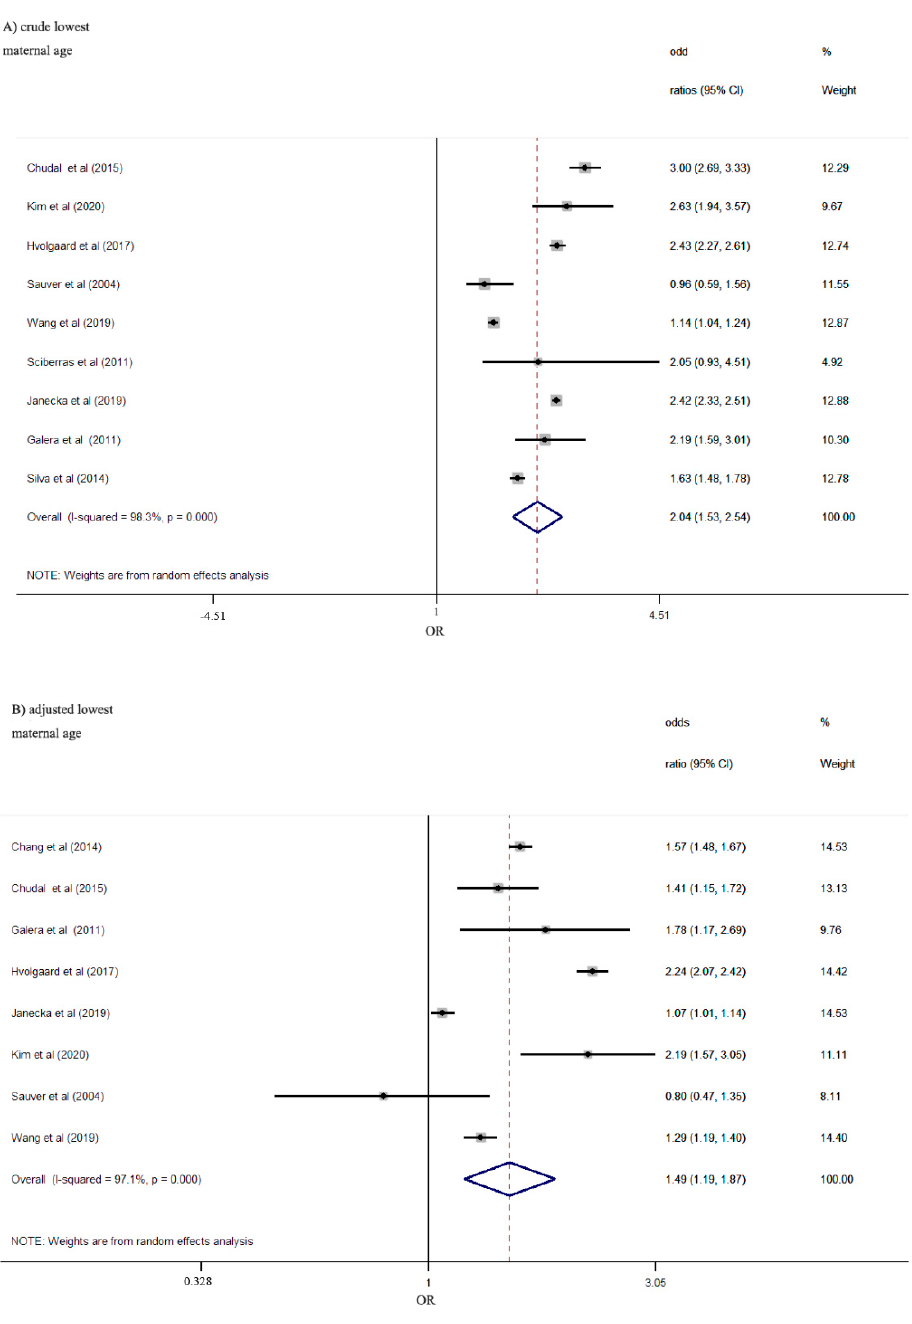
Figure 2. Risk of ADHD according to the lowest maternal age category vs. reference points. Pooled crude effects ( A ) and adjusted effects ( B ) for maternal age from random-effects meta-analyses are shown.